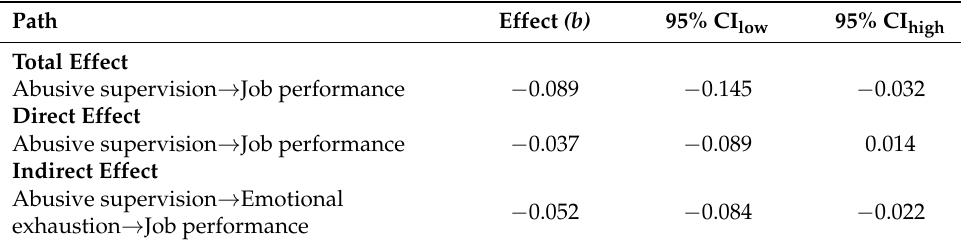
Table 3. Test of the mediating effect of emotional exhaustion on the abusive supervision–job perfor- mance